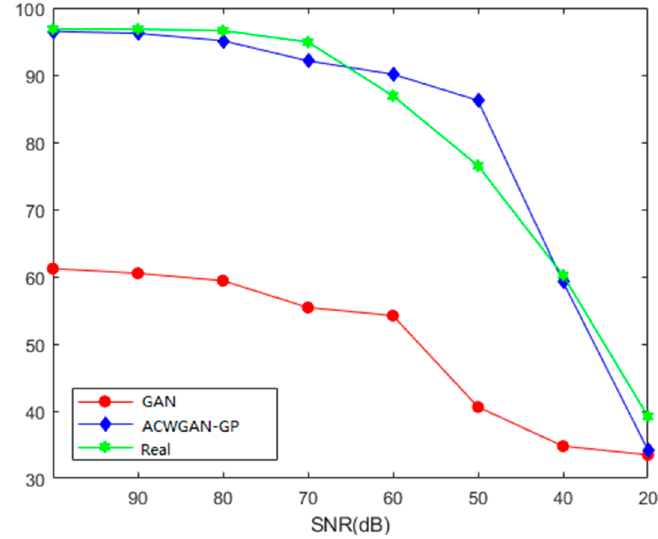
Figure 15. Classification accuracy in different noise environments.